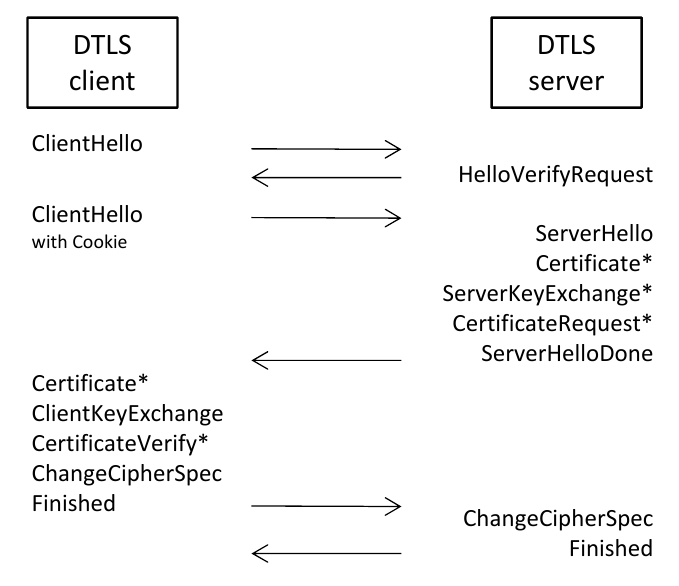
Figure 2. The full DTLS